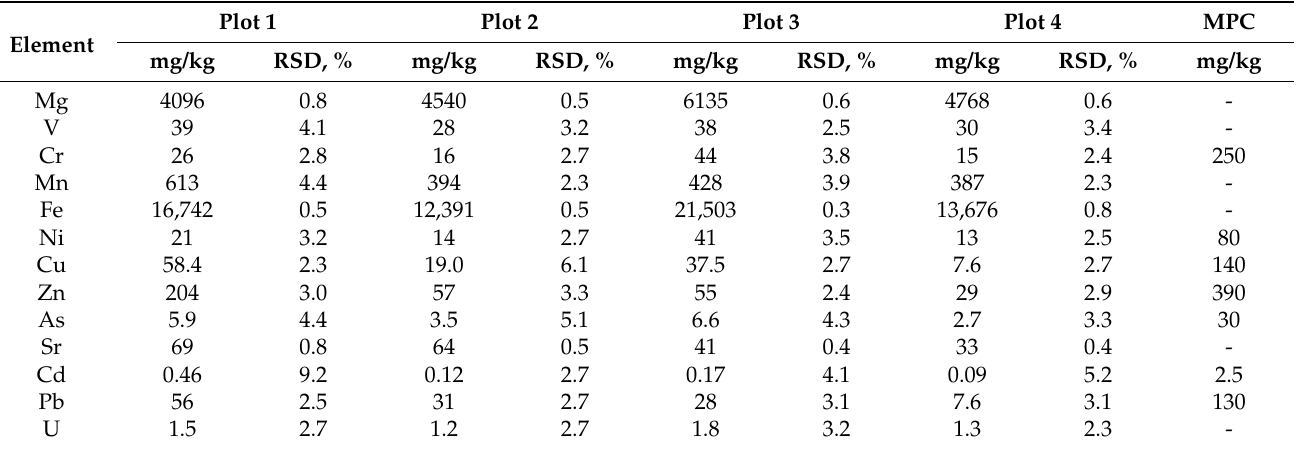
Table 2. Content of some chemical elements (mg/kg) in the studied urban soil samples and maximal permissible content (MPC) in urban soils according to the Bulgarian